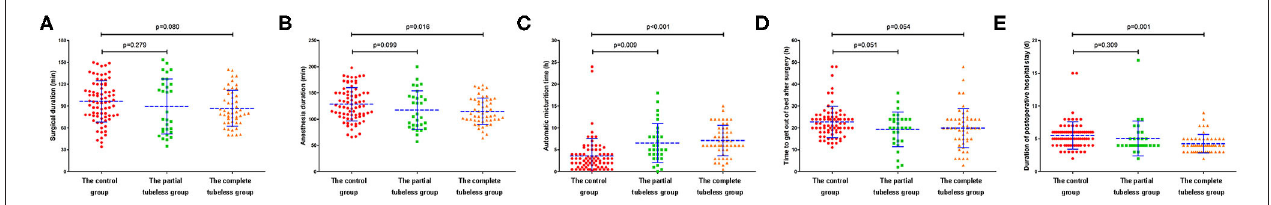
FIGURE 4 | Operation and anesthesia duration and postoperative recovery among groups. (A) Operation duration for the three groups; (B) anesthesia duration for the three groups; (C) automatic micturition time for the three groups; (D) time to get out of bed after surgery for the three groups; (E) duration of postoperative hospital stay for the three groups.